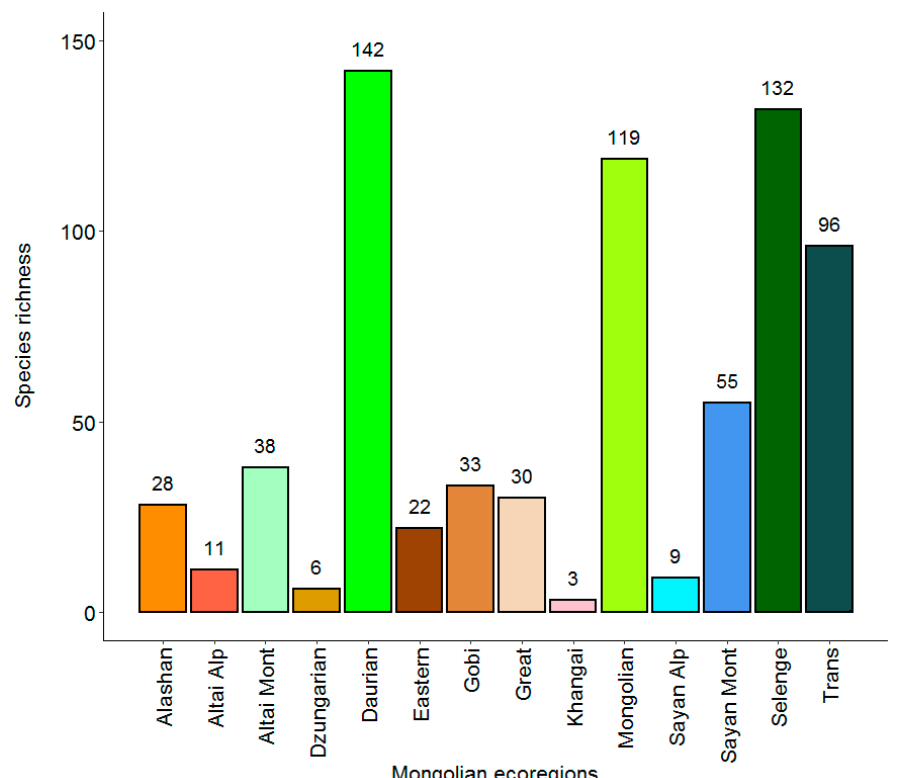
Figure 4. Geometrid moth species richness of 14 ecoregions of Mongolia. Under-sampled ecoregions are Altai Alp, Dzungarian, Khangai, and Sayan Alp. Colors refer to the map in Figure. 1. Ecoregion